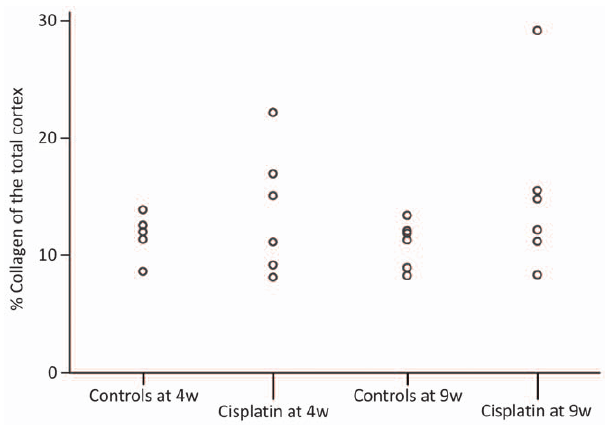
Figure 1. % Collagen of the total cortex. Effect of cisplatin on the quantity of collagen in the renal cortex. Sirius red-stained sections of all rats were scanned, the total amount of collagen was measured and expressed as percentage of the total cortex. Data are presented per group per rat. Statistics were performed using generalized linear